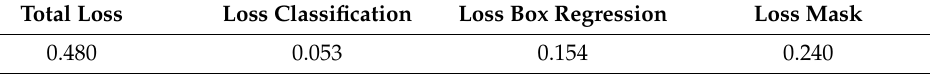
Table 11. Summary of model losses.